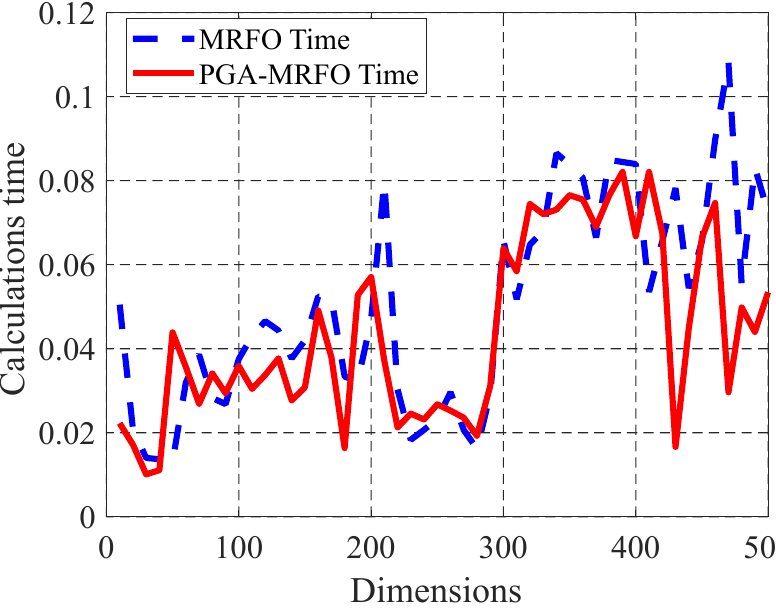
Figure 21. Calculations time of MRFO and PGA ‐ MRFO.